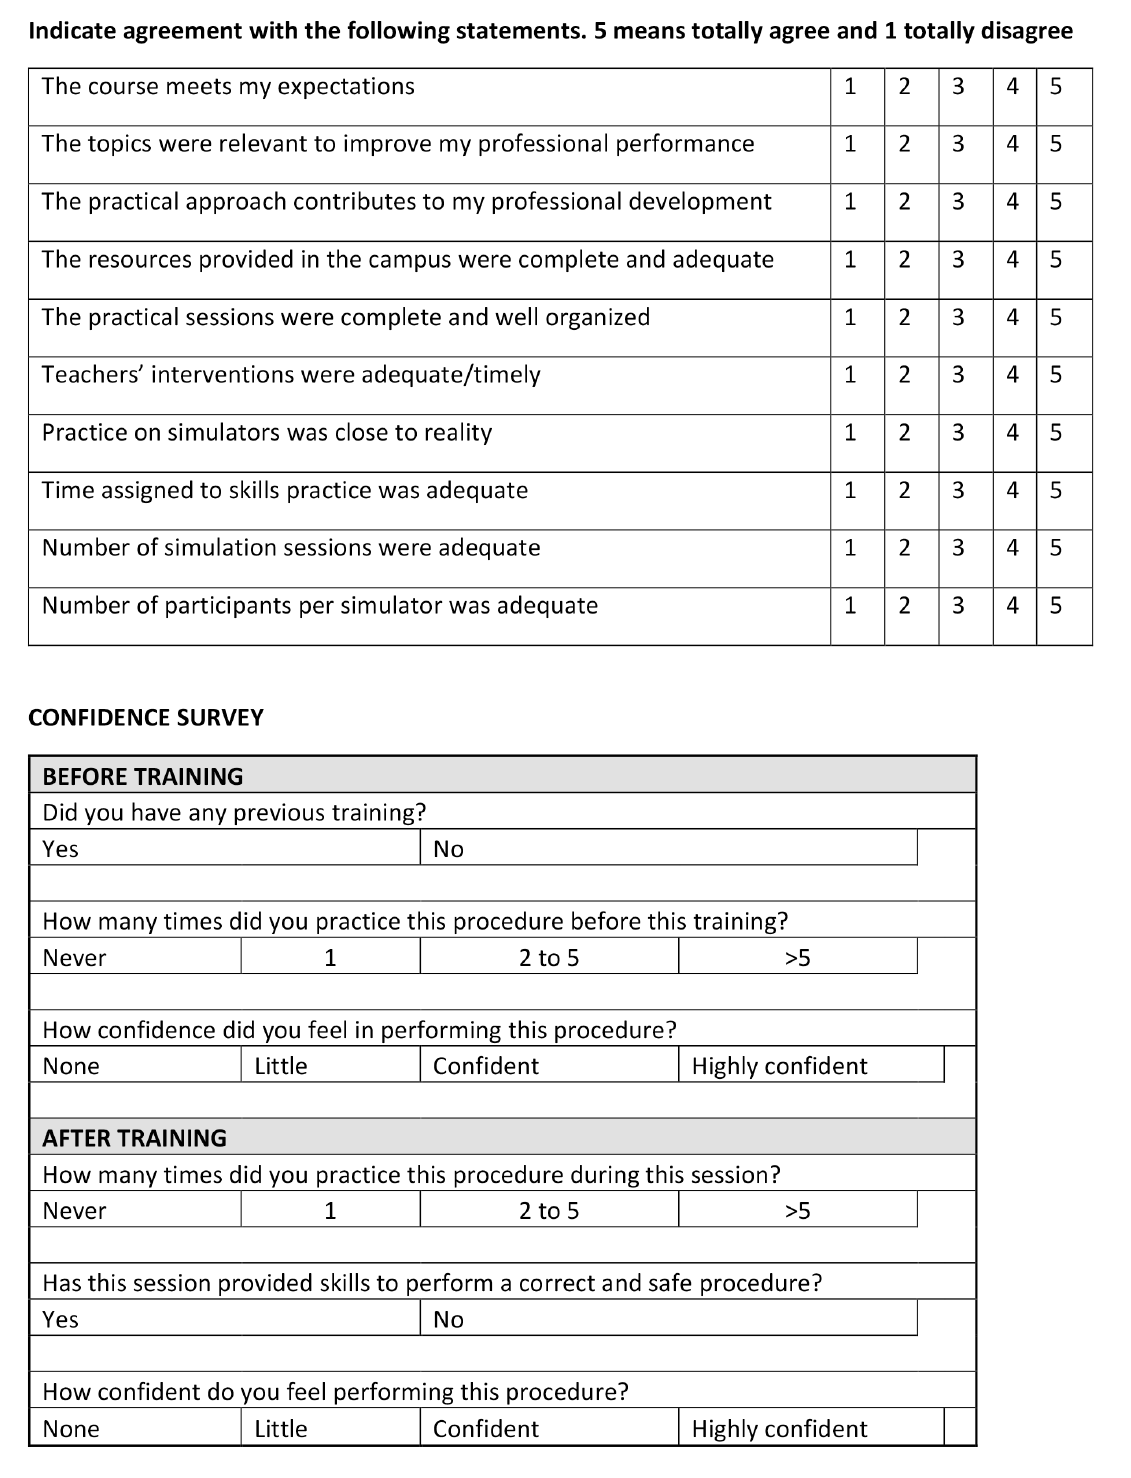
Fig. 1 - Survey after each teaching